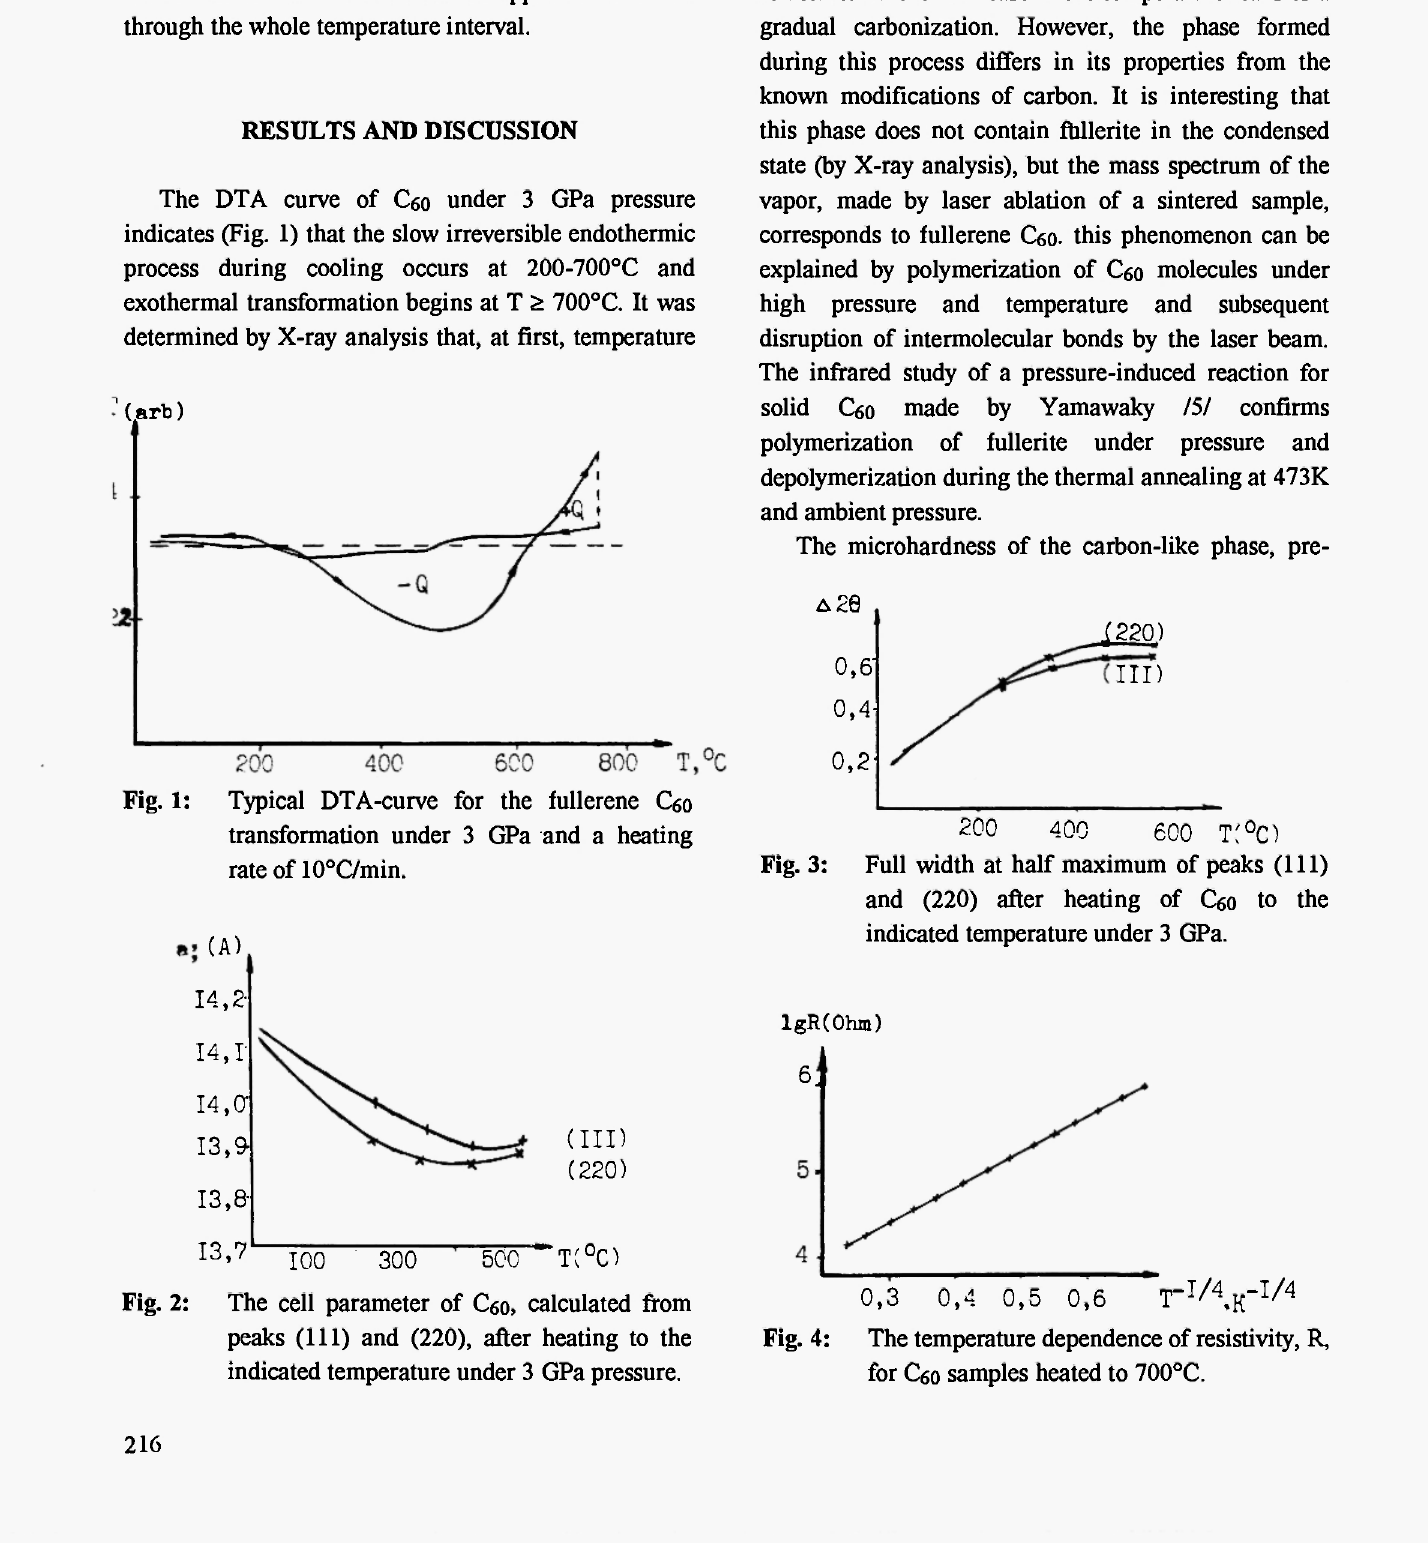
Fig. 2: The cell parameter of Cöo, calculated from peaks (111) and (220), after heating to the indicated temperature under 3 GPa pressure.